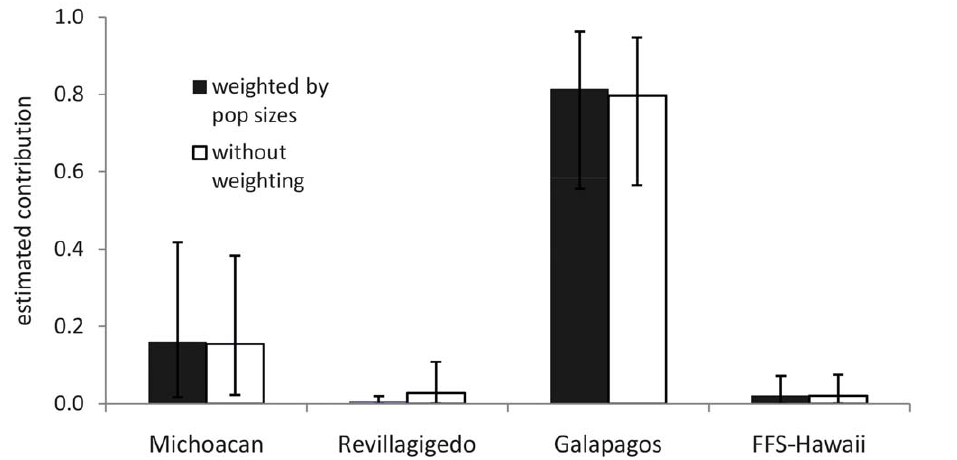
Figure 4. Bayesian mixed stock estimates of contributions to the Gorgona foraging ground by central and eastern Pacific rookeries, after excluding putative western Pacific ‘‘orphan’’ haplotypes. Dark bars represent results using source population sizes (nests/yr) information; light bars without source population size. Source haplotype profiles used were obtained for Michoacan and Revillagigedo (Mexico), Galapagos (Ecuador) and French-Frigate Shoals Hawaii (USA). Error bars represent 97.5% and 2.5% percentile